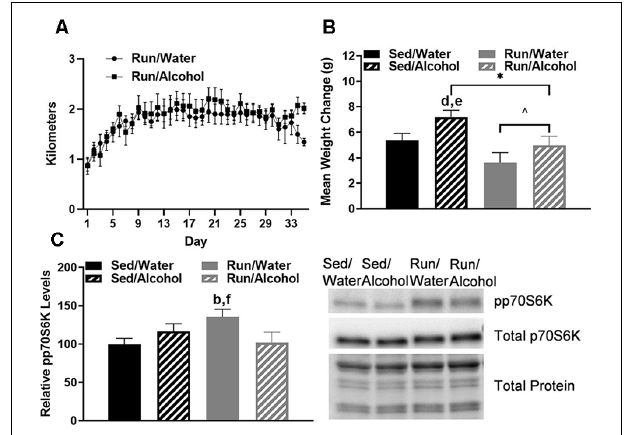
FIGURE 1 | Daily running distance and related phosphorylated p70S6K marker for muscle protein synthesis. (A) Average daily running distances ( ± SEM) for mice throughout the study. (B) Average weight change throughout the study, and (C) western blot analysis containing the relative optical density for phosphorylated p70S6K corrected for total protein in mouse gastrocnemius muscle (left) and representative blot images